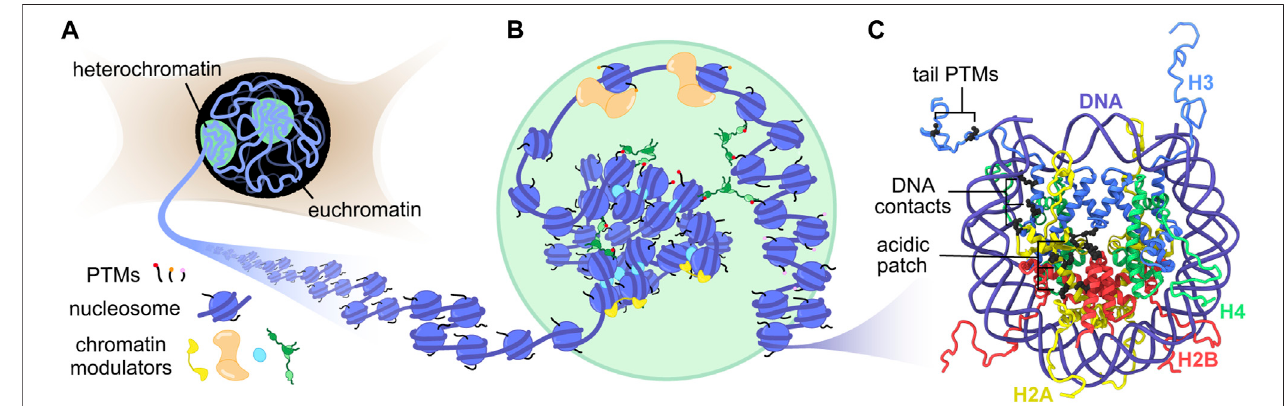
FIGURE1| Genome organization fromthenucleus tothenucleosome. (A) Thenucleuscontainstwodistinctchromatin states, heterochromatin and euchromatin. Compact heterochromatin compartments may form by phase separation. (B) Chromatin fi bers in different states contain distinct PTM signatures and interact with speci fi c chromatin modulators. (C) The structure of the nucleosome with highlighted regions of interest for MAS NMR studies (PDB:1KX5) (Davey et al., 2002).